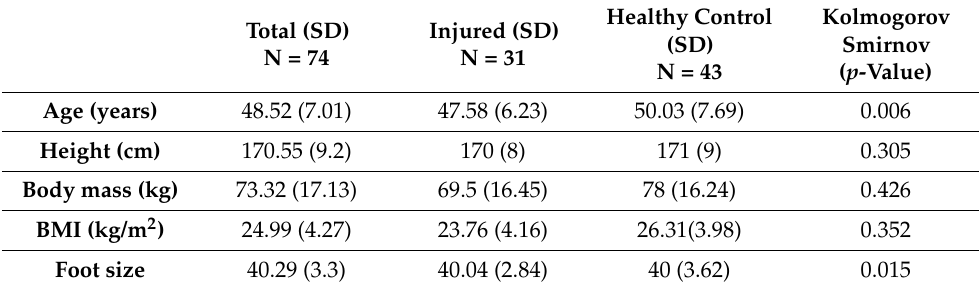
Table 1. Anthropometric characteristics of both sample